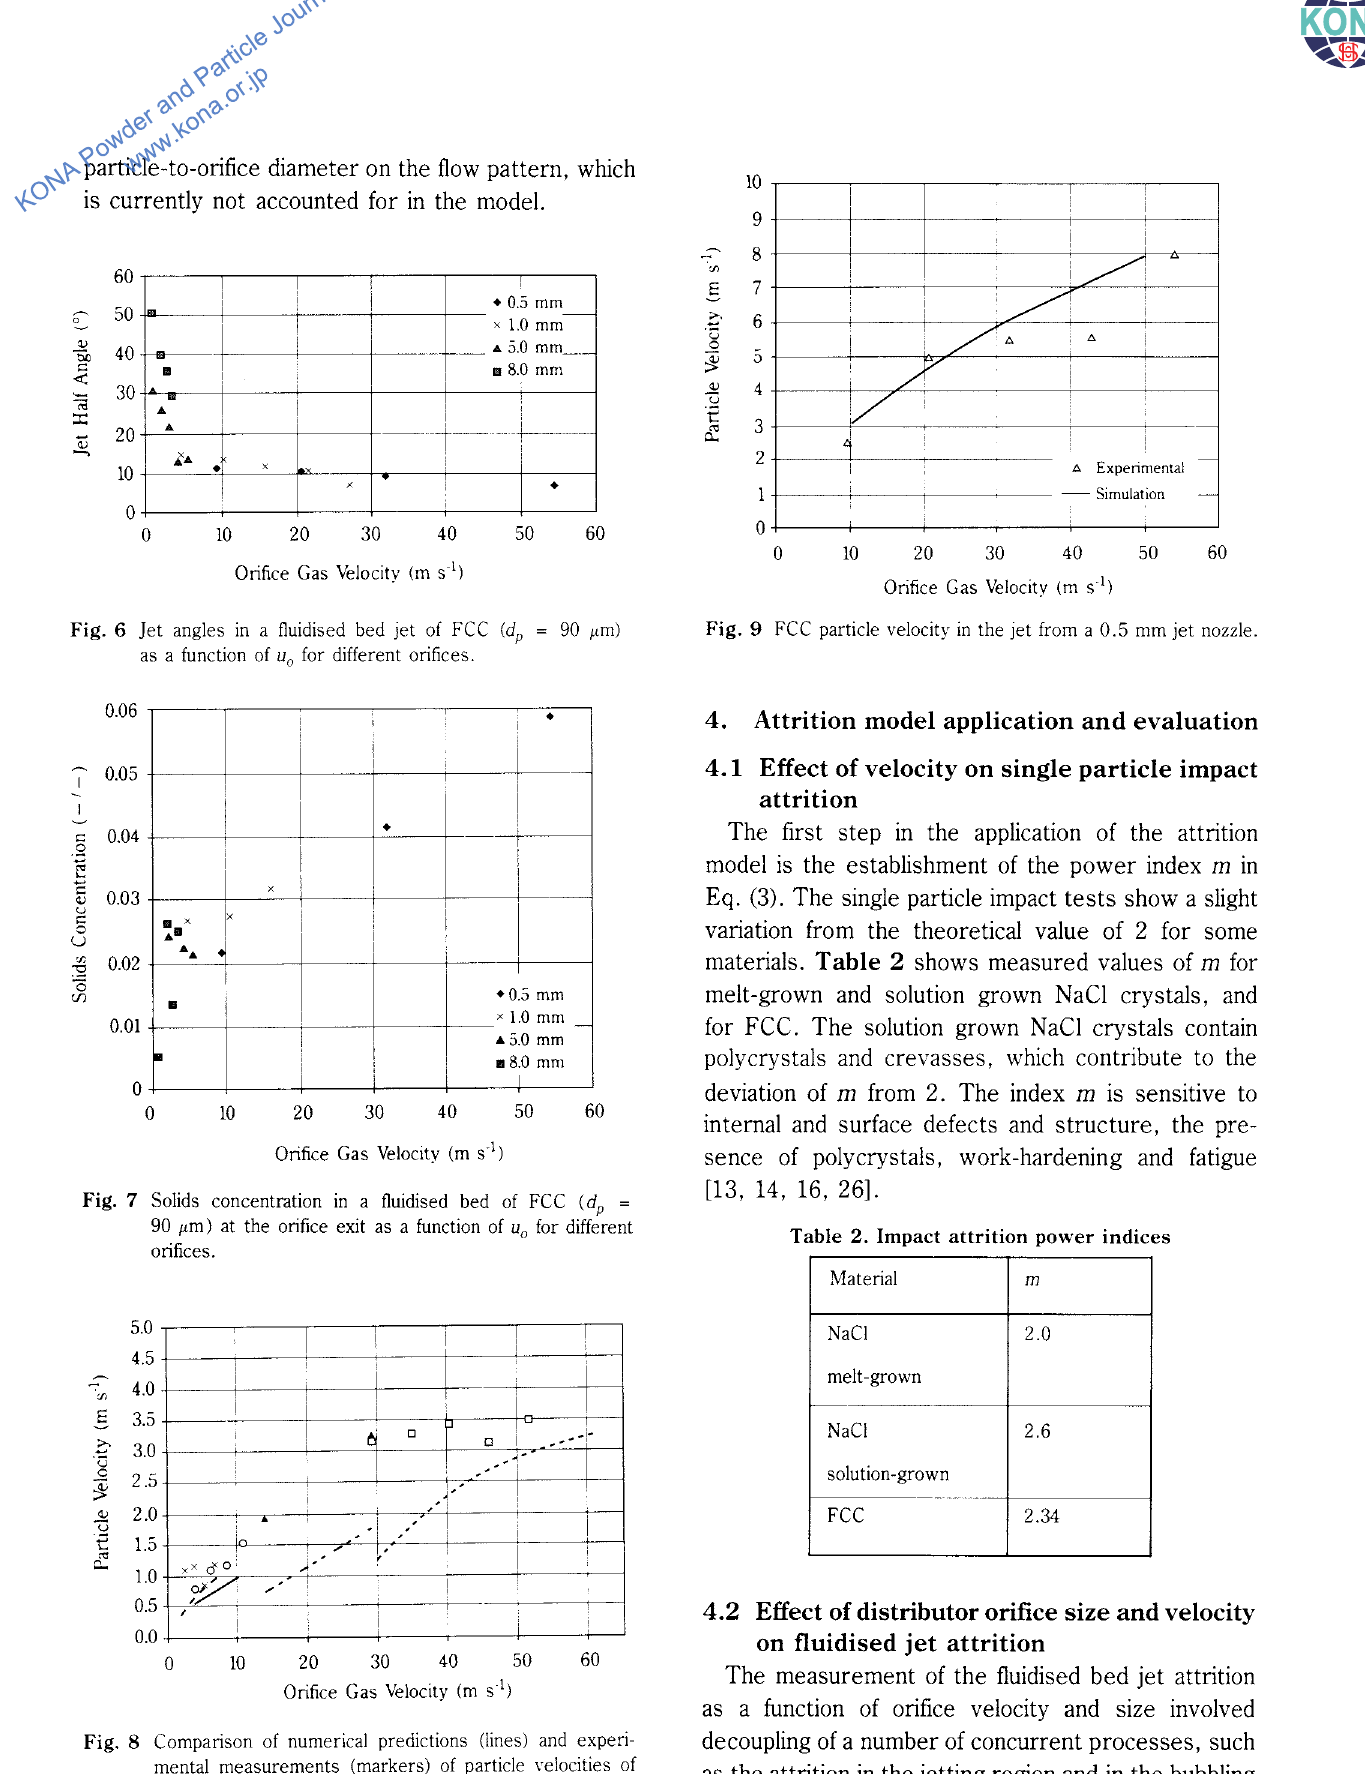
= 5.0 mm; =. · · · · ·; 0 ,. d r = 0.2 mm. 0